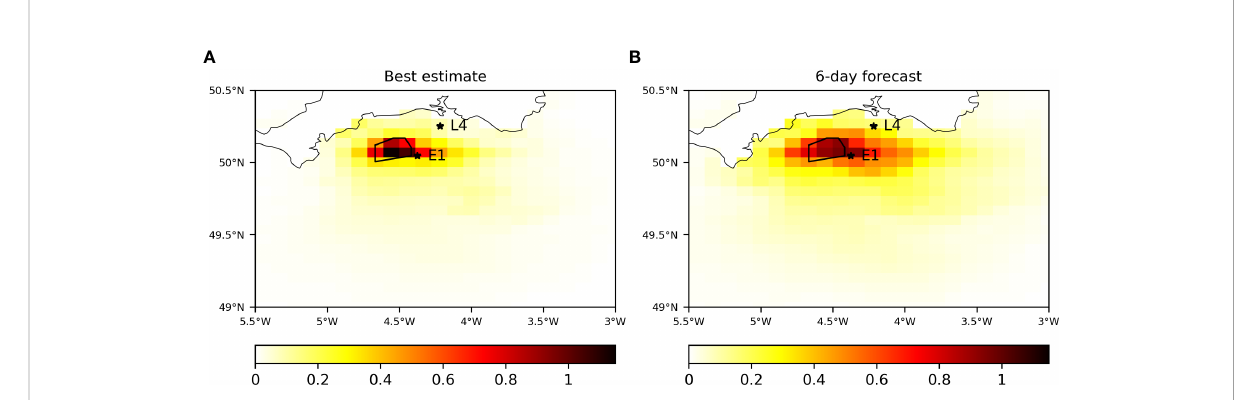
FIGURE 6 Mean absolute difference in surface chl- a (mg m -3 ) between AMM7-CAMPUS and AMM7-OPER during the glider deployment, computed for (A) the fi rst analysis day and (B) the six-day forecast. The black polygon shows the region in which the glider was permitted to travel. The stars show the location of the E1 and L4 time series